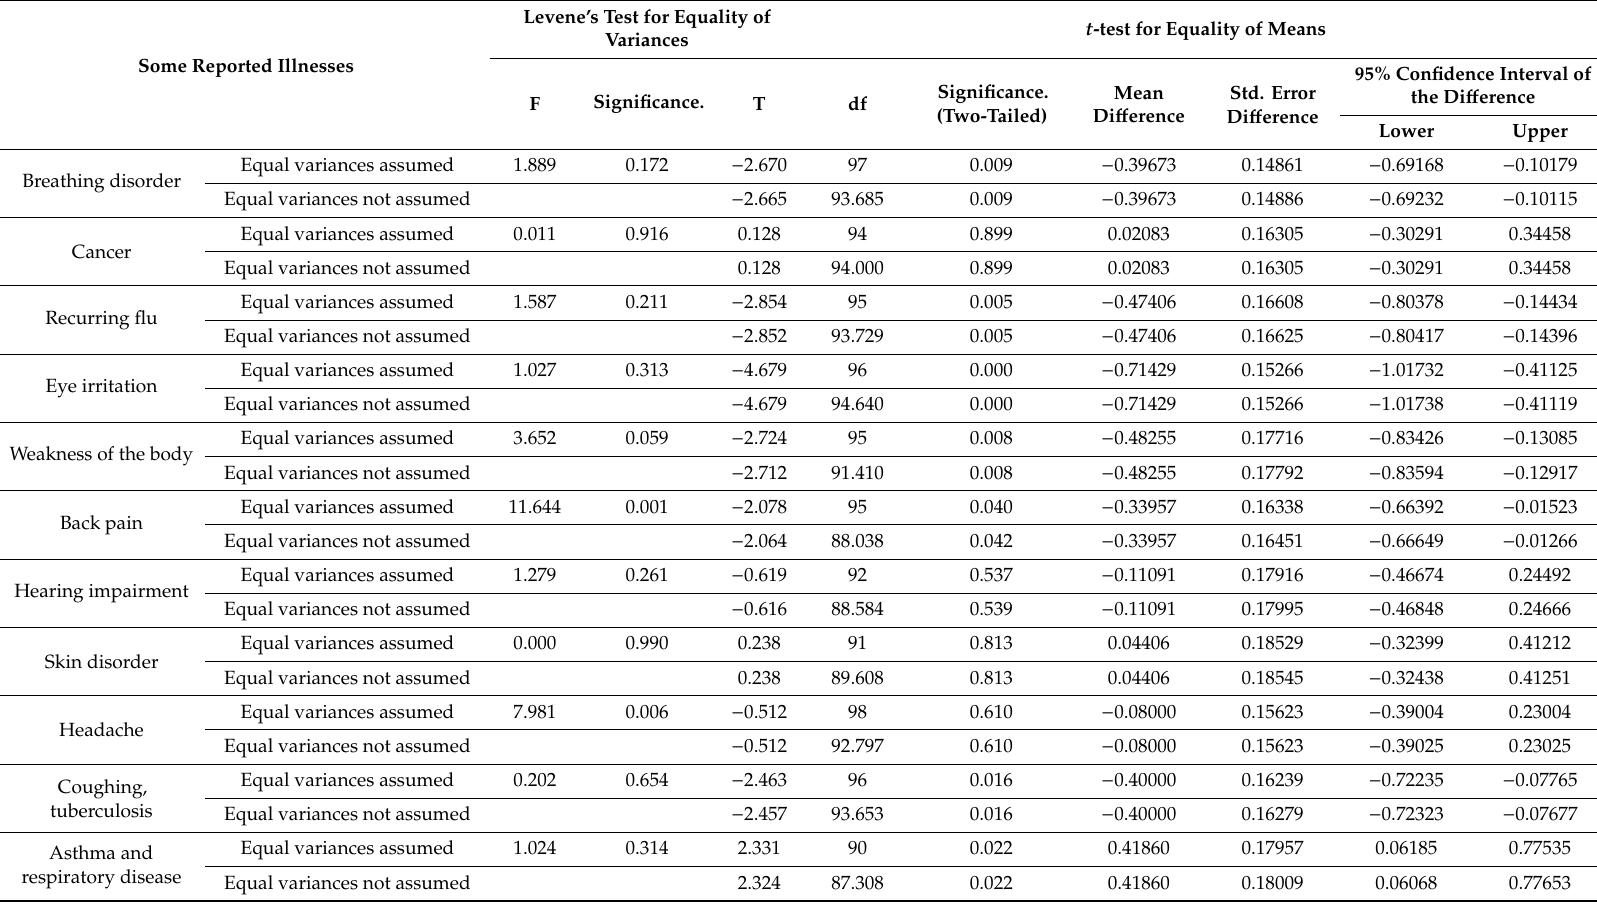
Table A2. Independent samples test on most reported illnesses encountered by the participants in both